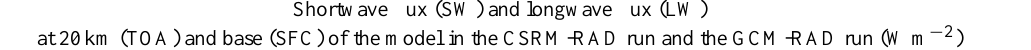
Table 2. Time- and area-averaged net shortwave radiation flux (SW) and longwave radiation flux (LW) at 20km (TOA) and base (SFC) of the atmosphere for the CSRM-RAD run and the GCM-RAD run.